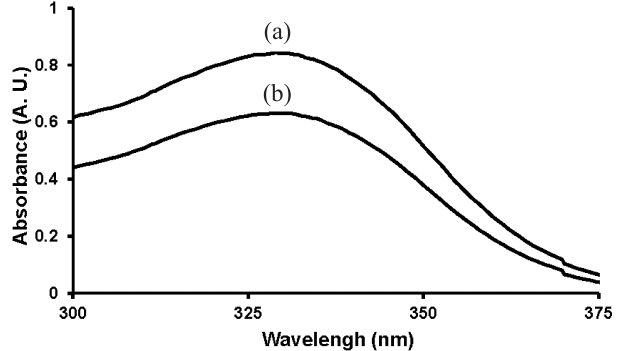
Fig. 7. Absorption spectra of (a) 4-nitroaniline (indicator) and (b) Fe 3 O 4 @ZrO 2 -SO 3 H (catalyst) in CCl 4 .